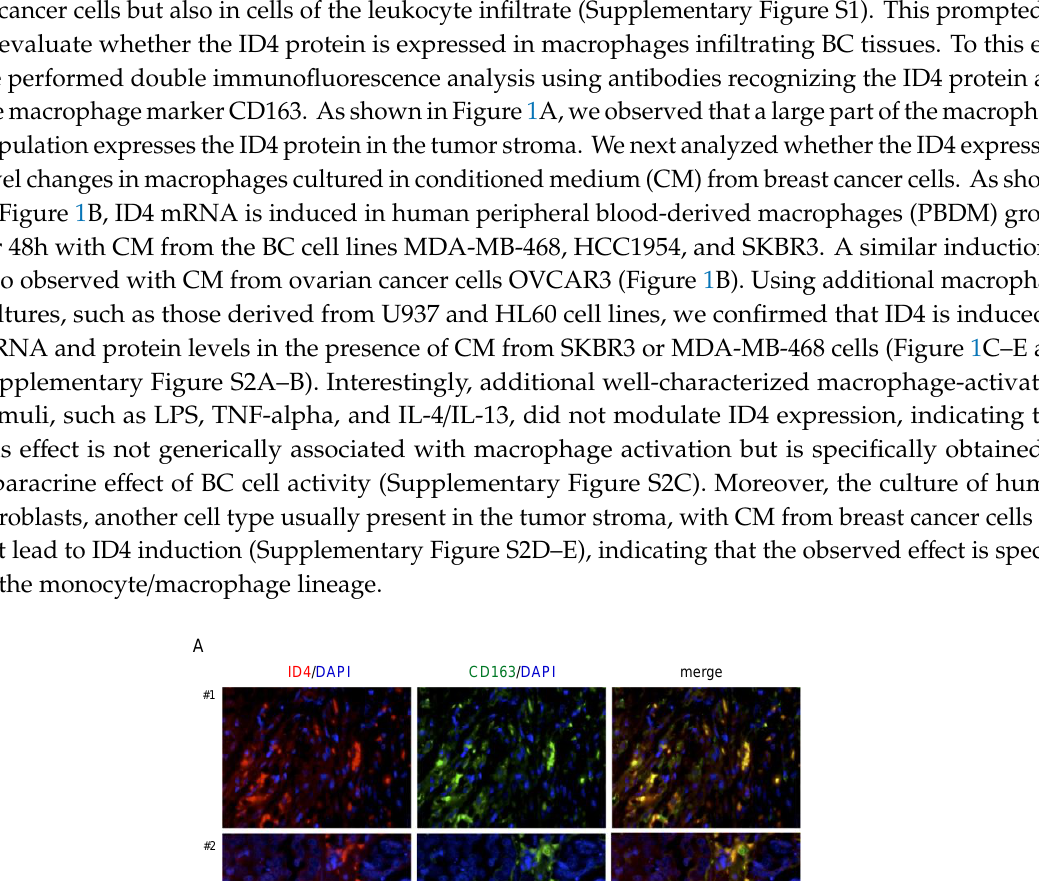
Figure 1. ID4 expression is induced in macrophages cultured with conditioned media (CM) from breast and ovarian cancer cells. ( A ) ID4 and CD163 protein expression evaluated by double immunofluorescence in tumor stroma (FFPE tissue sections from two breast cancer cases). ( B ) ID4 mRNA expression evaluated by RT-qPCR in macrophages, obtained from differentiation of peripheral blood-derived monocytes (PBDM), cultured with RPMI serum free (SF), RPMI 2.5% FBS or conditioned medium (CM) from the indicated breast (MDA-MB-468, HCC-1954, SKBR3) and ovarian (OVCAR3) cancer cells. Relative expression was assessed by normalizing to GAPDH levels. Data are presented as the mean of the expression observed in two donors ± standard error. ( C – D ) ID4 mRNA expression in differentiated U937 cells, cultured with RPMI medium or with CM from the indicated breast cancer cell lines for the indicated time. ( E ) ID4 protein expression analyzed by Western blot in differentiated U937 cells cultured in RPMI medium or in CM from MDA-MB-468 (CM 468) or SKBR3 breast cancer cell lines for 24 h.